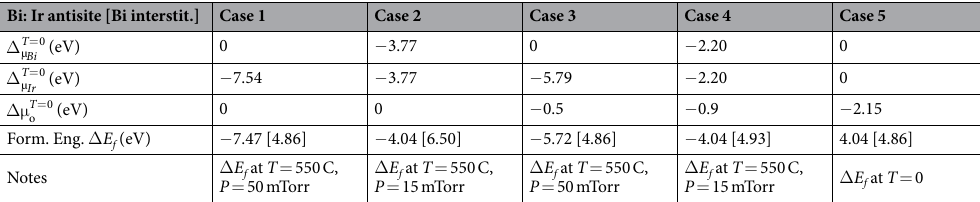
Supplementary Fig. S3. A qualitative comparison between the spectra of the films and that of the bulk IrO 2 (and Bi 2 O 3 ) (see Supplementary Fig. S4) suggests that both Ir (and Bi) have a component with an oxidation state lower than the nominal + 4 (and + 3). We fitted the spectra using two components in CasaXPS software to obtain more quantitative information. The symmetric component is described by the Gaussian-Lorentz profile GL(m), while the asymmetric lineshape which is used to capture the many-body, screening effects 52 is described by the con- volution of Gelius profile A(a,b,n) and Gaussian-Lorentz profile GL(m), in which the assymetry is determined by the parameters a and b. More detailed information about the fitting process is provided in the supplemental information. The fitting spectra at the optimal a and b values are shown in Fig. 3. The obtained binding energies for Ir 4f 5/2 peaks are: 65.8~66.1 eV (component 1) and 64.4~64.5 eV (component 2); the binding energies for Ir 4f 7/2 peaks are: 62.8~63.1 eV (component 1); and 61.4~61.5 eV (component 2). The existence of two components may be attributed to the apperance of two final states in the photoemission process 53, 54 , the coexistence of the core lines and plasmon satellite 55, 56 , and a mixed oxidation state 57 . In either case, however, the fact that the entire measured spectra are shifted to lower binding energies in comparison to IrO 2 (Ir 4 + ) suggests the formation of oxygen vacancies in the films. Similarly, the Bi spectrum can be fitted using two components as well (Fig. 3(b)): binding energies of 163.8~164.1 eV (component 1) and 163.0~163.2 eV (component 2) for the 4f 5/2 peak; and 158.5~158.8 eV (component 1) and 157.7~157.9 eV (component 2) for the 4f 7/2 peak. Again the binding energies being lower than for Bi 3 + indicates the presence of oxygen deficiency.